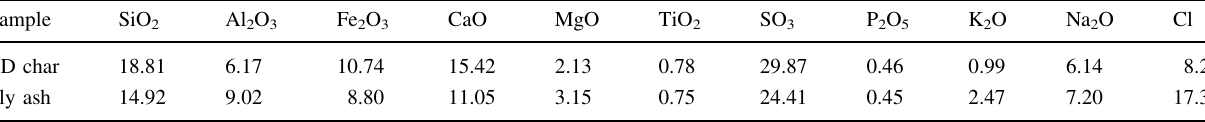
Table 5 Ash compositions of ZD char and fly ash